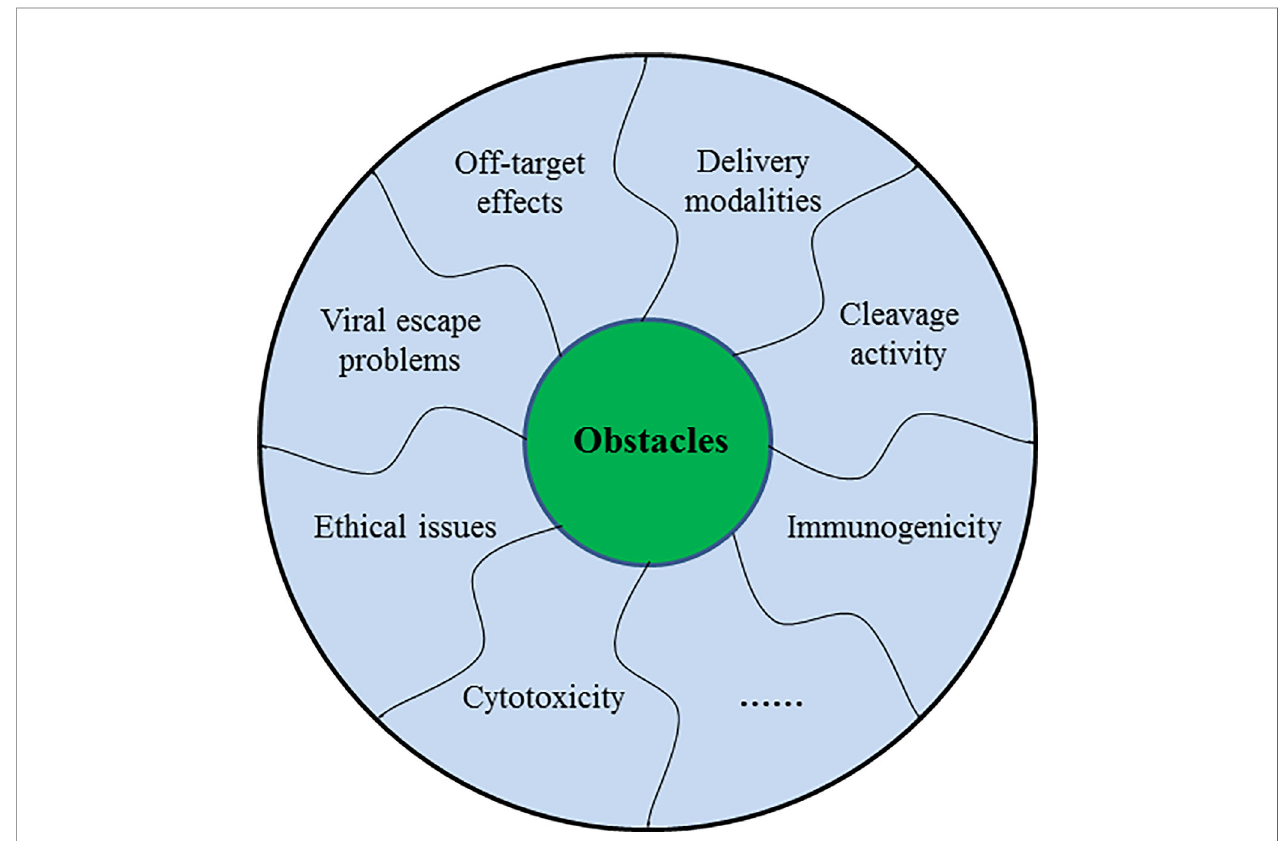
FIGURE 5 | The schematic diagram showing several challenges of CRISPR/Cas9 in the treatment of human infectious